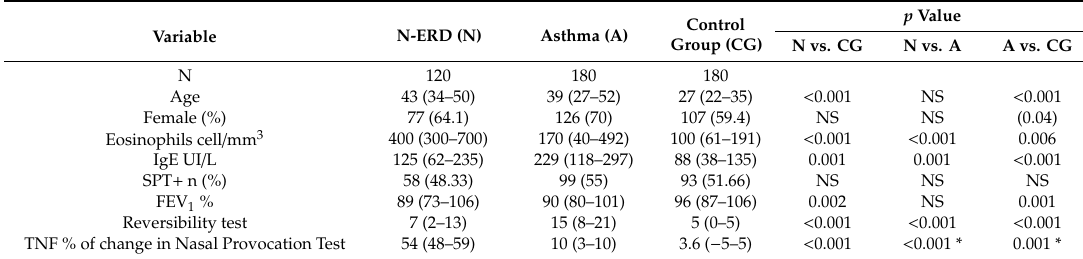
Table 1. Demographic and clinical characteristics of the first